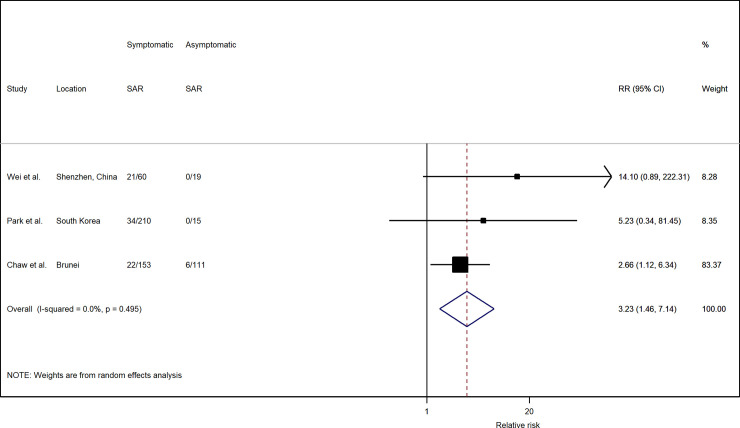
Forest plot of household transmission risk by symptom status of index case.RR is the estimated risk ratio, with 95% confidence intervals (CI). I-squared is the percentage of between-study heterogeneity that is attributable to variability in the true effect, rather than sampling variation.